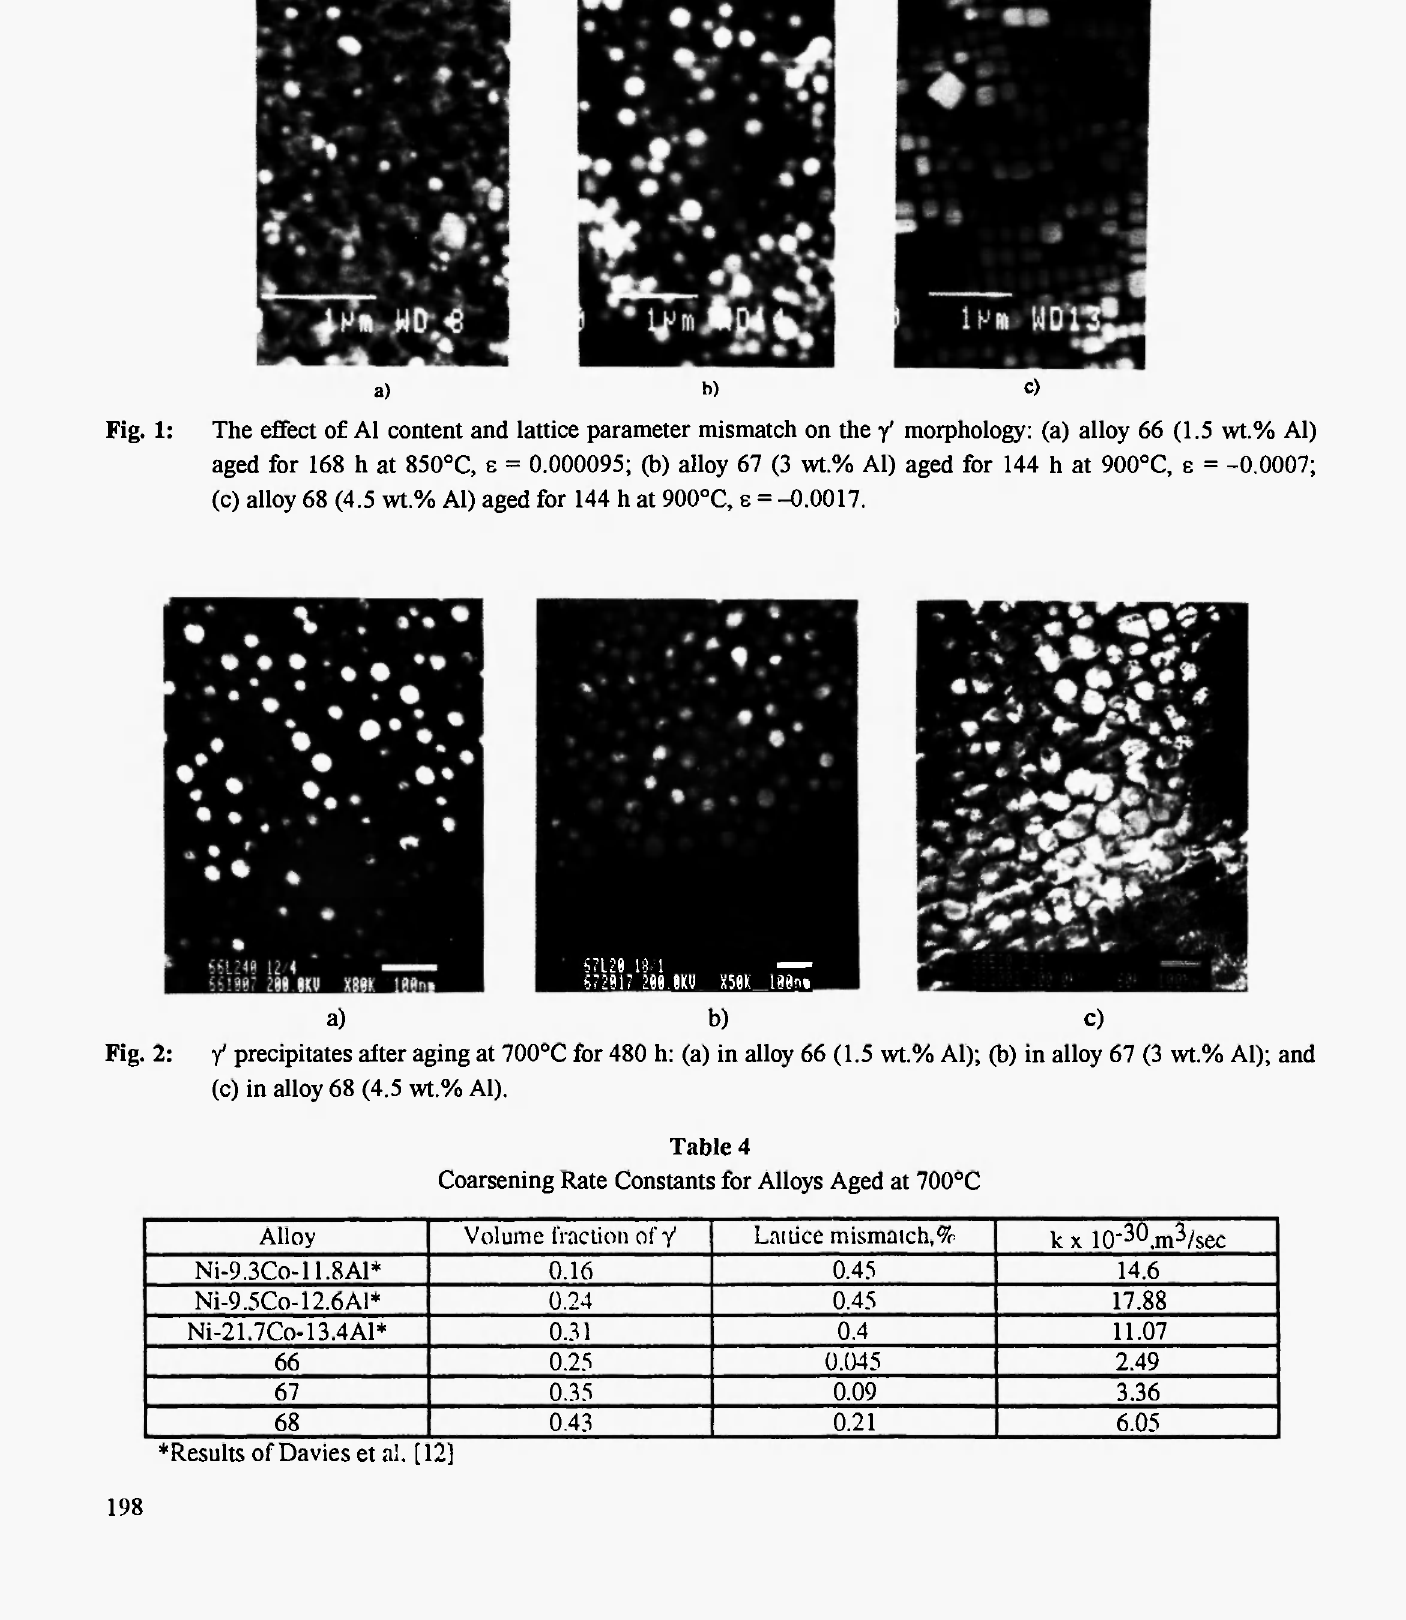
Fig. 2: γ precipitates after aging at 700°C for 480 h: (a) in alloy 66 (1.5 wt.% Al); (b) in alloy 67 (3 wt.% Al); and (c) in alloy 68 (4.5 wt.% Al).